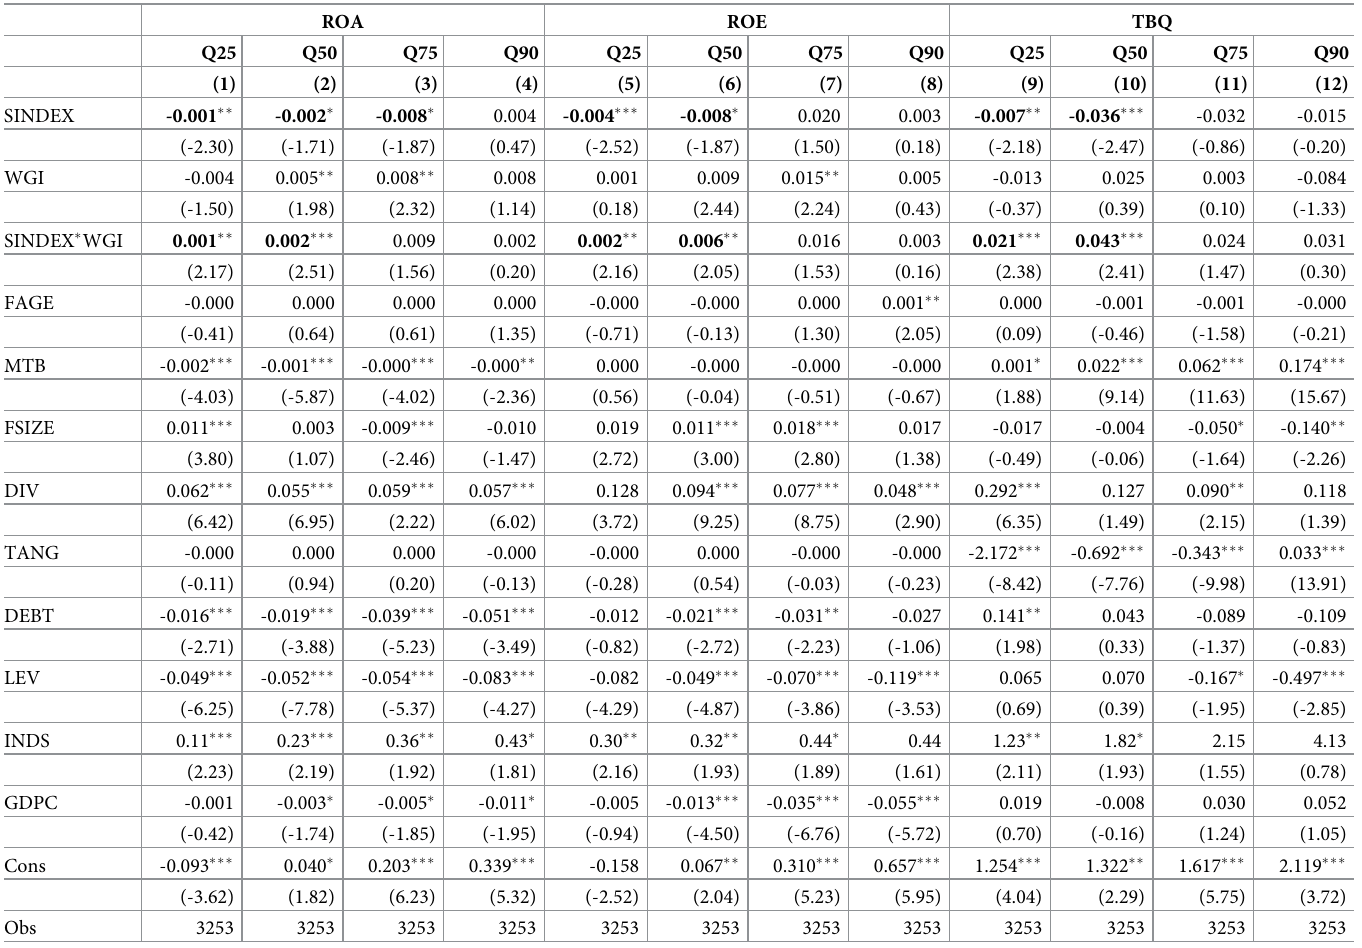
Table 10. Robustness test using the quantile regression method for firm